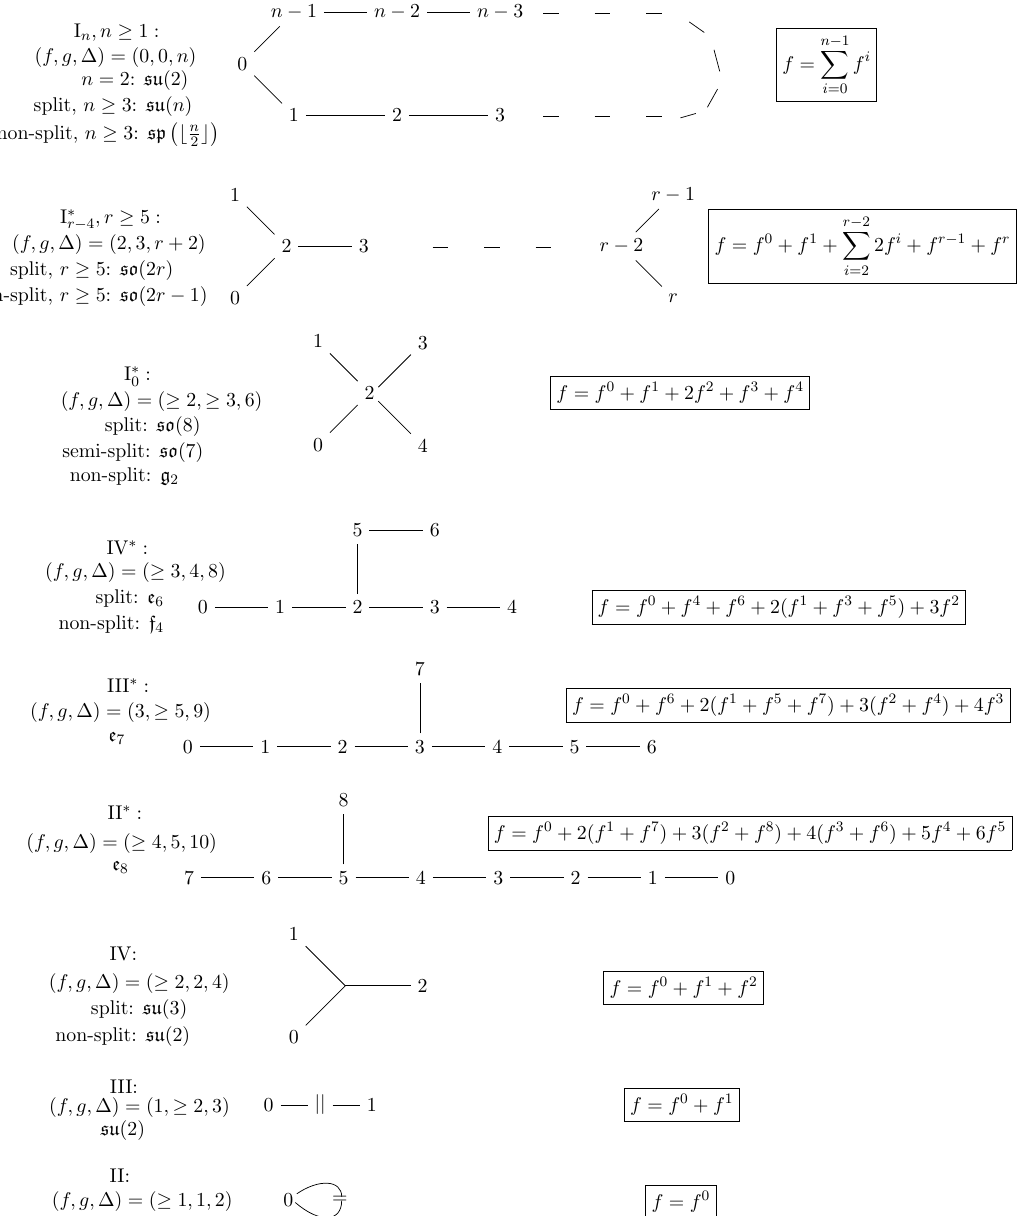
Figure 1 . Left: each Kodaira type is associated to an order of vanishing of f , g and (cid:1) which we denote as ( f; g; (cid:1)). We also display the corresponding 6 d gauge algebras which are di(cid:11)erent for split, semi-split and non-split cases. Middle: the graph displays the intersection pattern for the rational curves composing the elliptic (cid:12)ber. The numbers in the nodes of the graph are labels and each edge between two nodes corresponds to a transverse intersection of the corresponding rational curves. The components of type IV (cid:12)ber all intersect each other transversely at a common point. The in between the edges for types II and III denote the fact that those intersections jj are tangential rather than transverse. Right: the elliptic (cid:12)ber f is written in terms of the rational curves f i where i is the label appearing in the